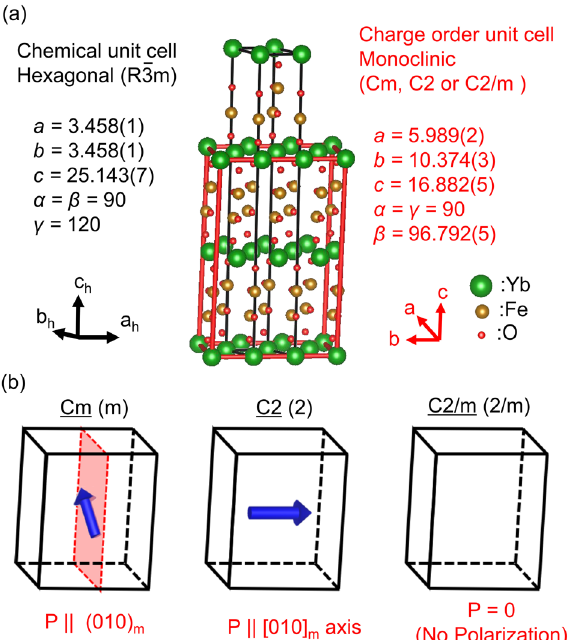
Figure 1. Crystal structure and symmetry of YbFe 2 O 4 . ( a ) Crystal structure of YbFe 2 O 4 . The black lines represent the chemical unit cell with a hexagonal structure (R3m) and the red lines denote the charge order unit cell with a monoclinic structure, which could have Cm, C2, or C2/m symmetry. The unit axes for the hexagonal cell (black) and the monoclinic cell (red) are included as insets. ( b ) The three candidates for the YbFe 2 O 4 space group: Cm, C2, and C2/m. The blue arrow represents the polarization directions for Cm and